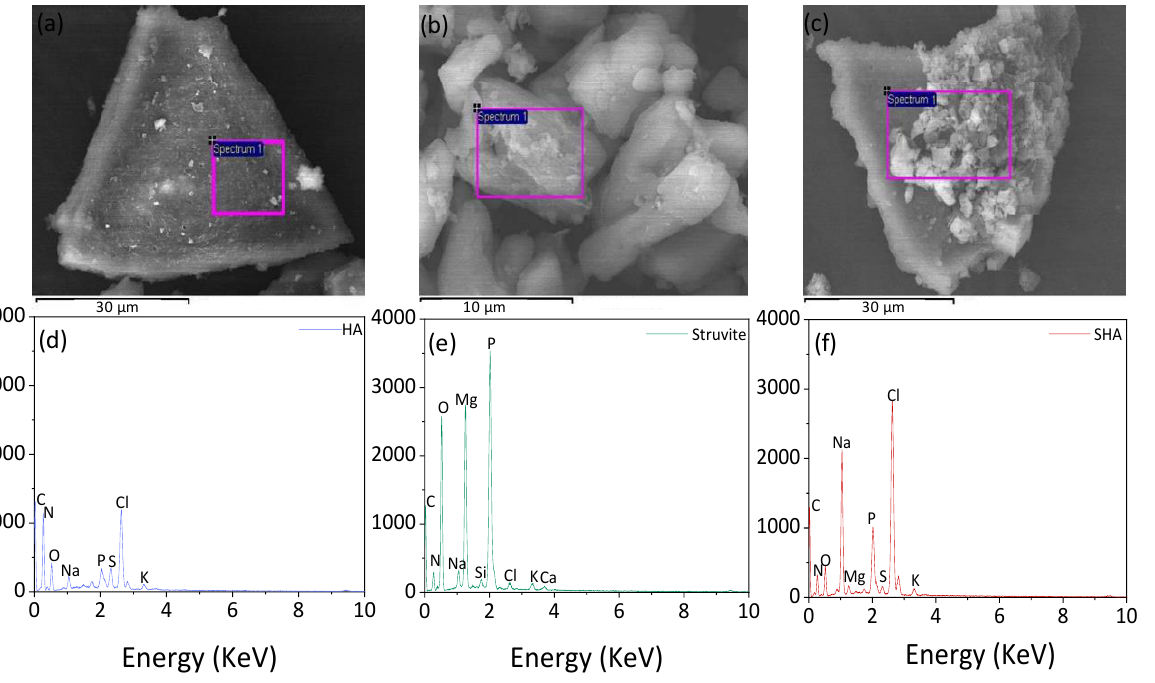
Figure 1. SEM micrographs for ( a ) humic acid, ( b ) struvite, and ( c ) struvite – humic acid composite and EDS spectra for ( d ) humic acid, ( e ) struvite, and ( f ) struvite – humic acid composite (HA: humic acid; S – HA: struvite – humic acid composite). Table 1. The elemental composition of struvite, humic acid, and struvite – humic acid composite. Element Struvite (%) Humic Acid (%)